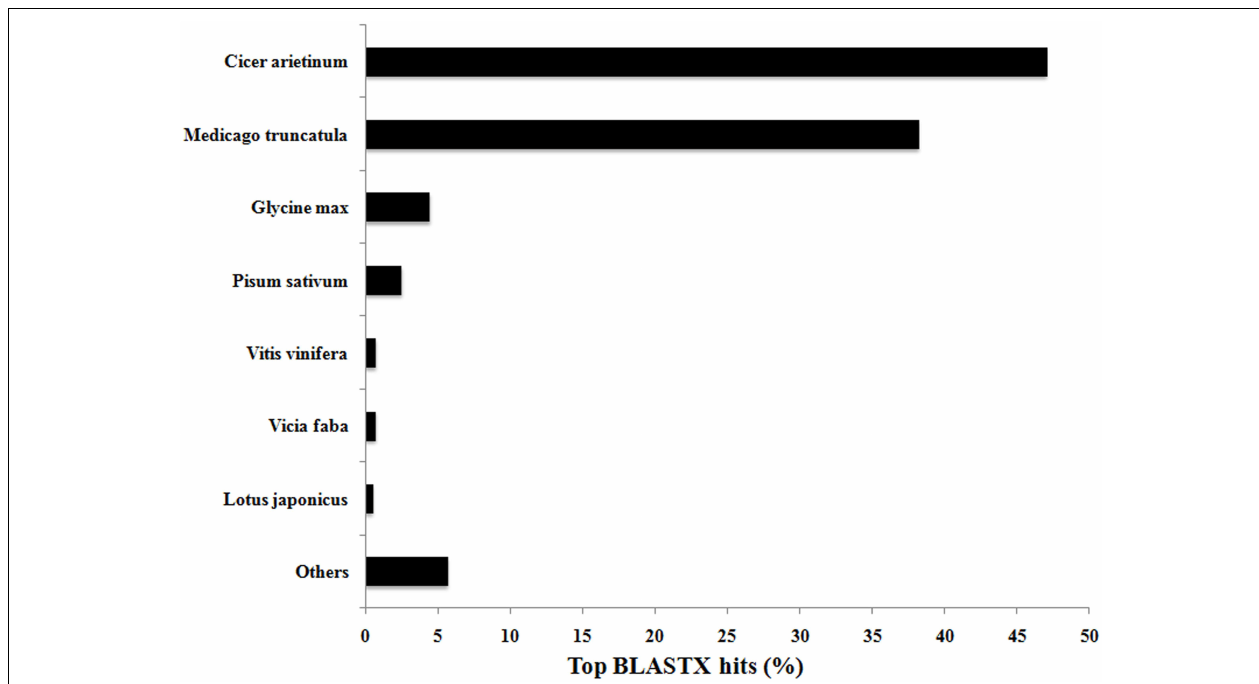
FIGURE 2 | Top BLASTX hits of V. faba contigs against the Viridiplantae database. Contig sequences of V. faba are highly conserved with closely related and sequenced legume species, with 85% of the contigs showing similarity with Cicer arietinum (chick pea) and Medicago truncatula.